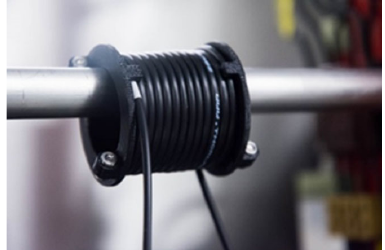
FIG. 3. Scintillator fibers are placed inside a plastic jacket to prevent ambient light leaking in, and wrapped around a holder mounted on the beam pipe at the location of interest. The generated light is guided via plastic optical fibers of the same 1 mm diameter as the scintillator fibers to the